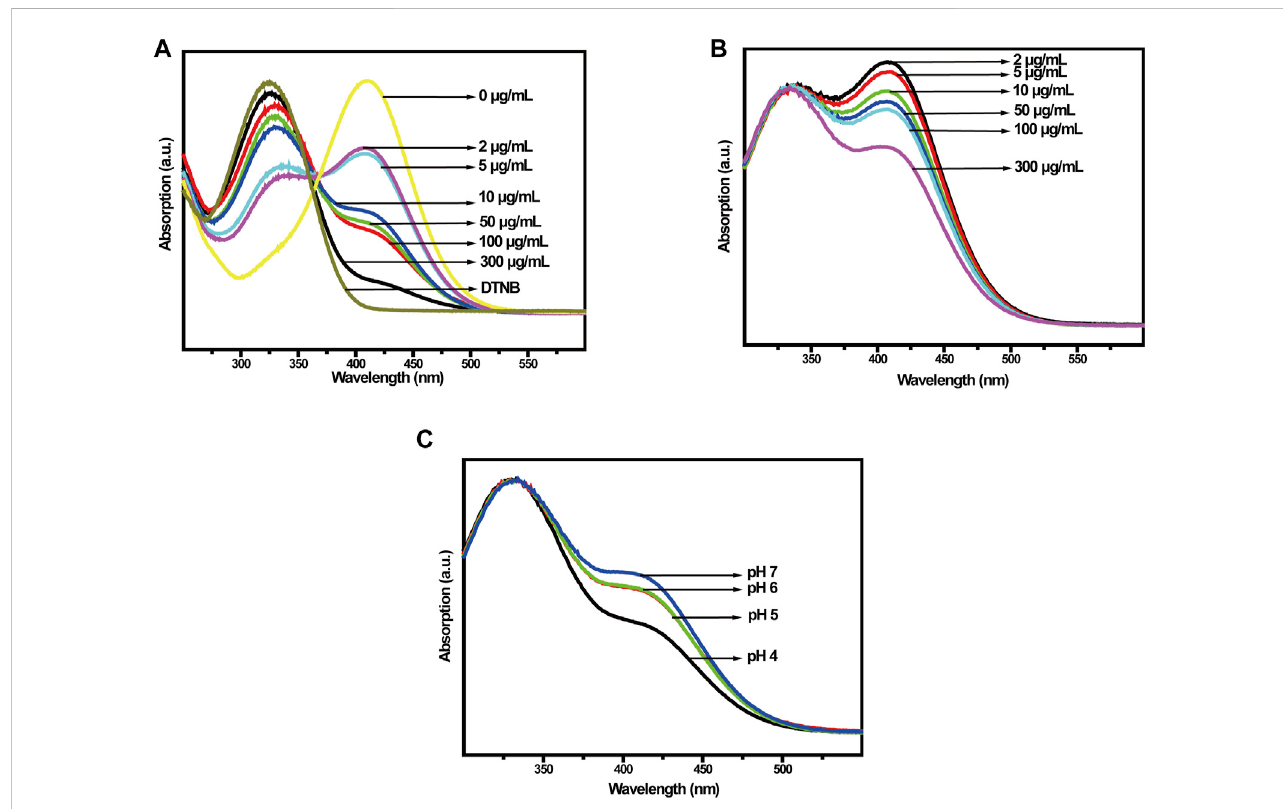
FIGURE 4 (A) UV-Vis spectra of Cu-MOFs and (B) Cu-MOFs@Keratin co-incubated with GSH at different concentrations; (C) UV-Vis spectra of GSH with different pH values after co-incubation with